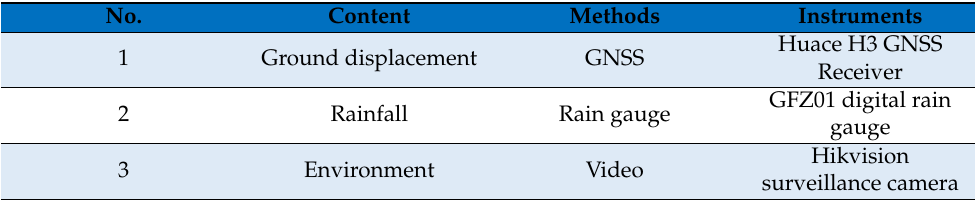
Figure 4. Location of landslide monitoring stations. Table 1. Monitoring content and methods.